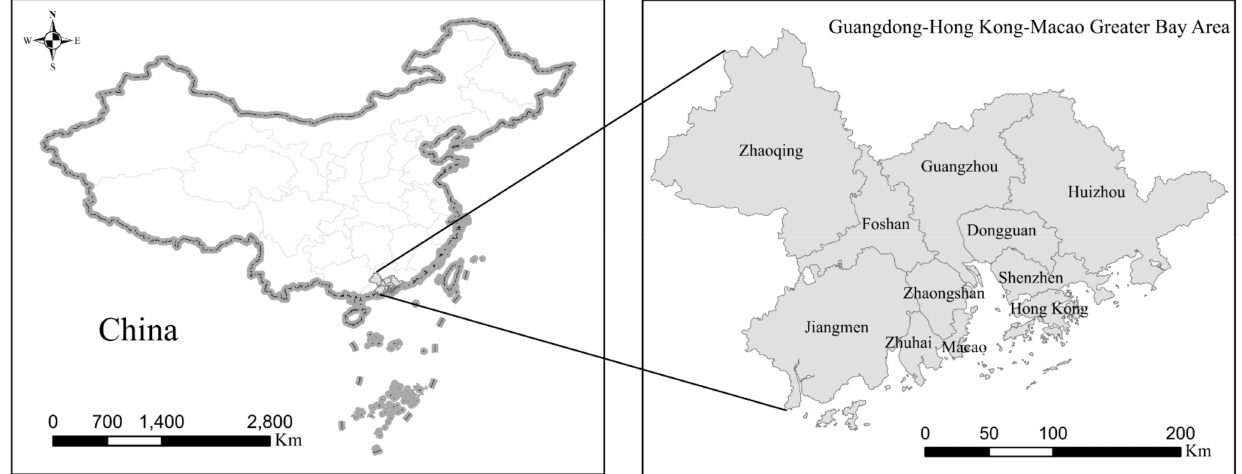
Figure 1. Guangdong–Hong Kong–Macao Greater Bay Area,